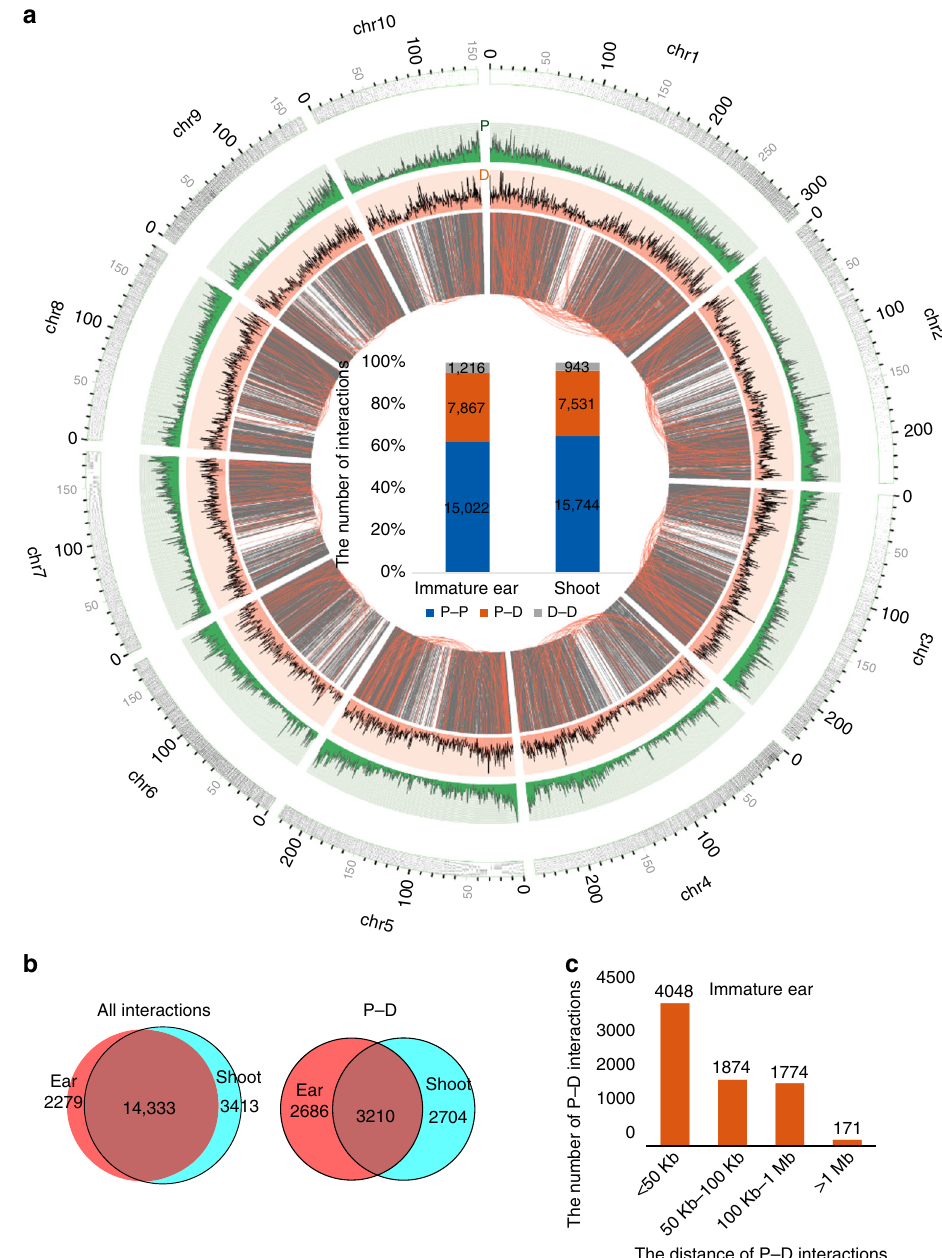
Fig. 3 Annotation of chromatin interactions. a Circos map of the whole-genome chromatin interactions from chromosome 1 to chromosome 10 in immature ear, generated using the Circos software package (http://circos.ca/). Intra-chromosomal interactions are drawn in the innermost ring, followed by the distal regulatory region (DR) (dark orange) and gene density track (dark green). Chromatin interactions with distance longer than 1 Mb are highlighted by orange arcs. The histogram in center region of Circos map showed the number of proximal – proximal (P – P), proximal – distal (P – D), distal – distal (D – D) chromatin interactions in immature ear and shoot, respectively. b Venn diagram of the number of P associated with all intra-chromosomal interactions and P – D interactions in immature ear and shoot. c Summary of the number of P – D interaction with variable distances in immature